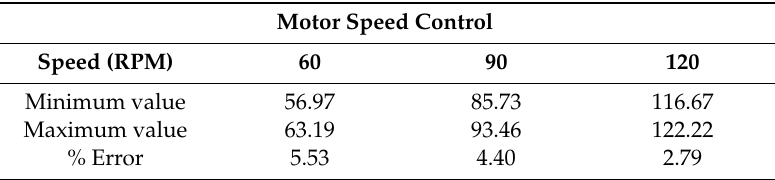
Table 3. Speed of rotating coil at a steady-state response.